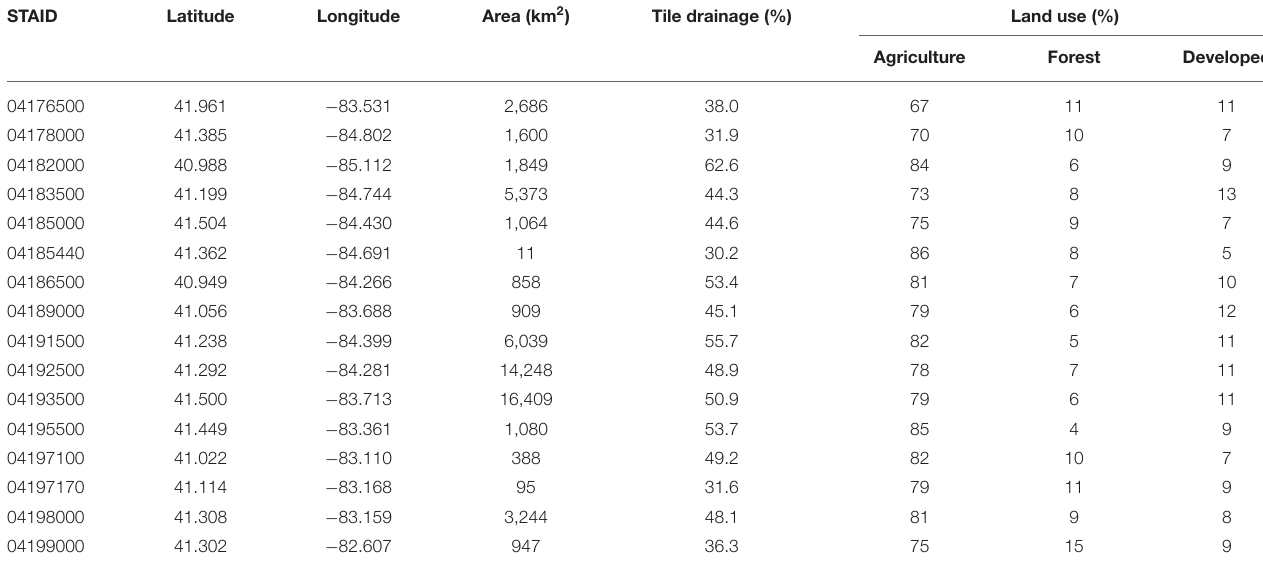
TABLE 1 | Location of stream gages and watershed characteristics.